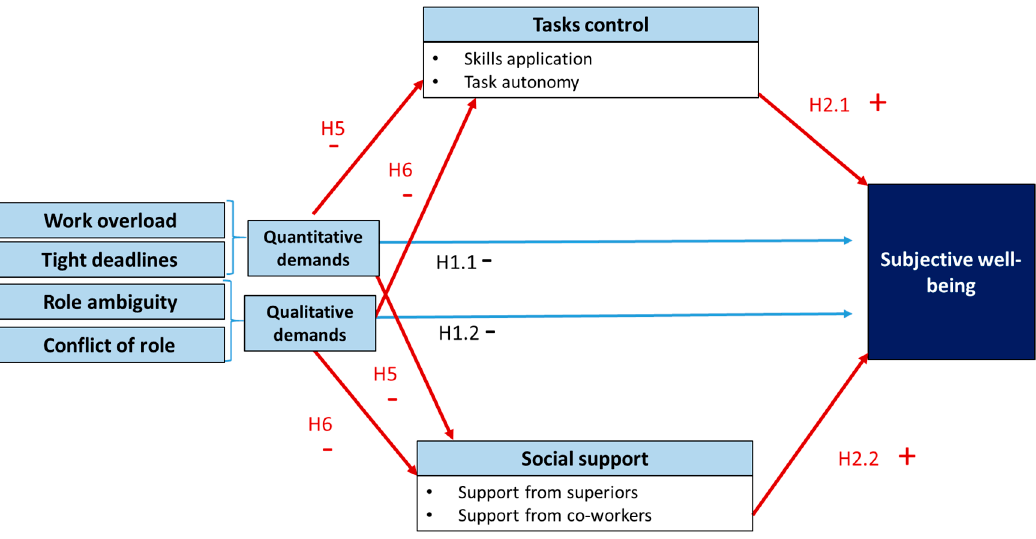
Figure 2. Model of the relationship between job demands, resources, and subjective well-being with the effect of mediator resources.